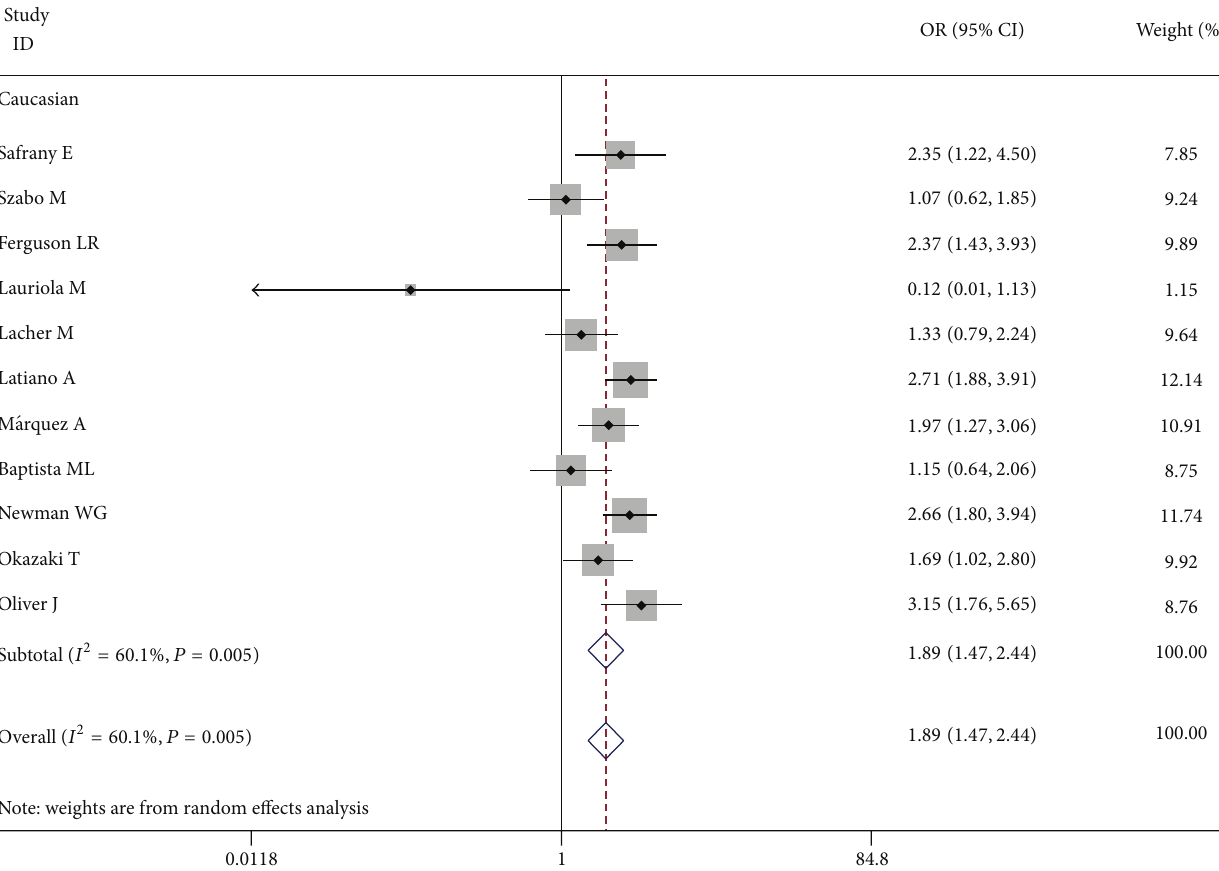
Figure 2: Forest plot for risk of CD associated with rs7517847 in Caucasian (TT versus GG. For each study, the estimate of OR and its 95% CI is plotted with a box and a horizontal line. Filled diamond pooled OR and its 95% CI).